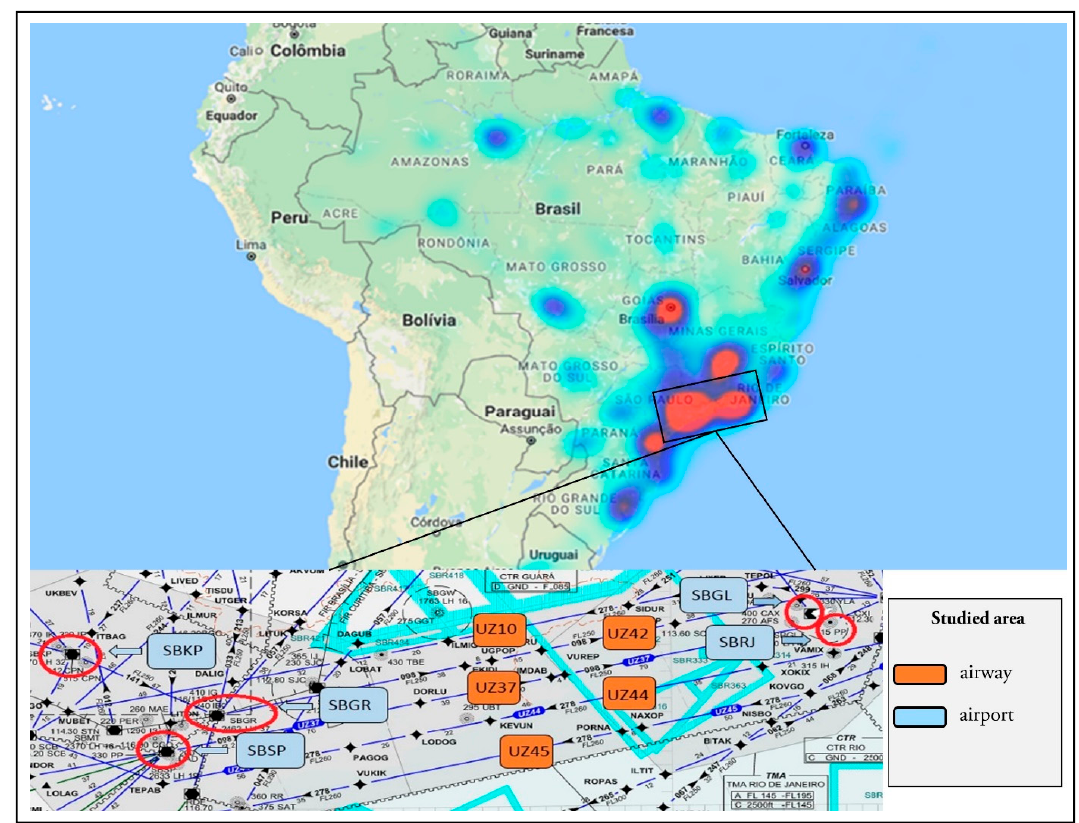
Figure 9. Heat map of the traffic density in Brazilian air space and the studied area air traffic structure. Source: The authors .